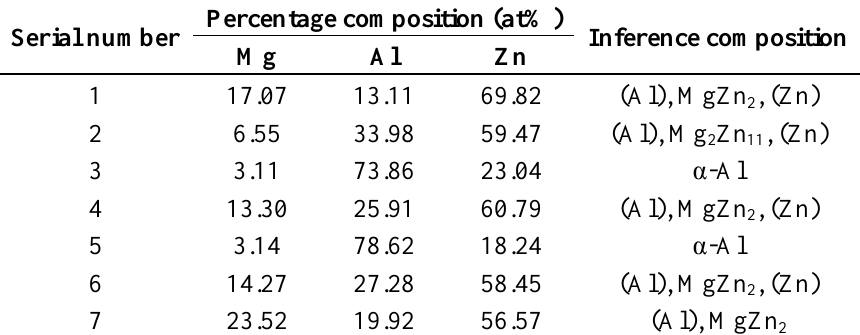
Table 4. The chemical compositions of different